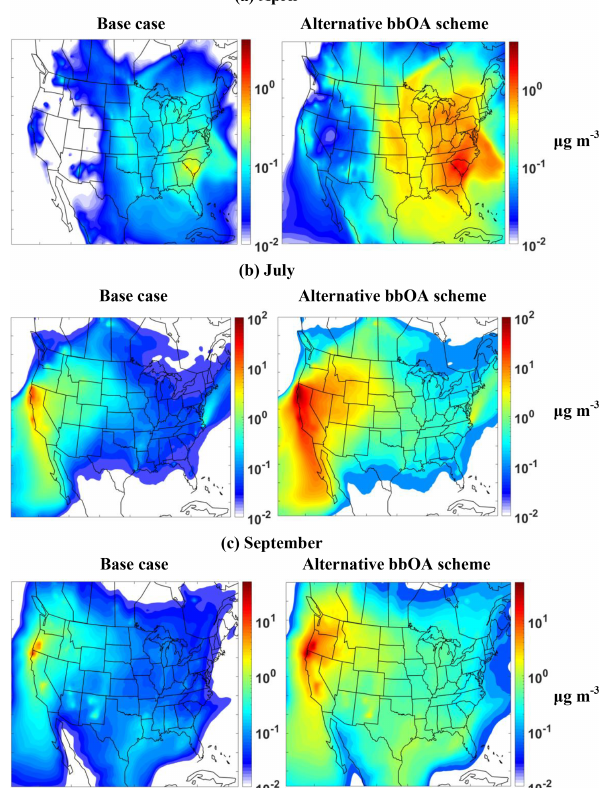
Figure 6. PMCAMx-SR-predicted ground-level concentrations of bbOA from all biomass burning sources during (a) April, (b) July, and (c) September 2008. Left column refers to the base case simula- tions and right column to the simulations with the alternative bbOA scheme. All concentrations are in µgm − 3